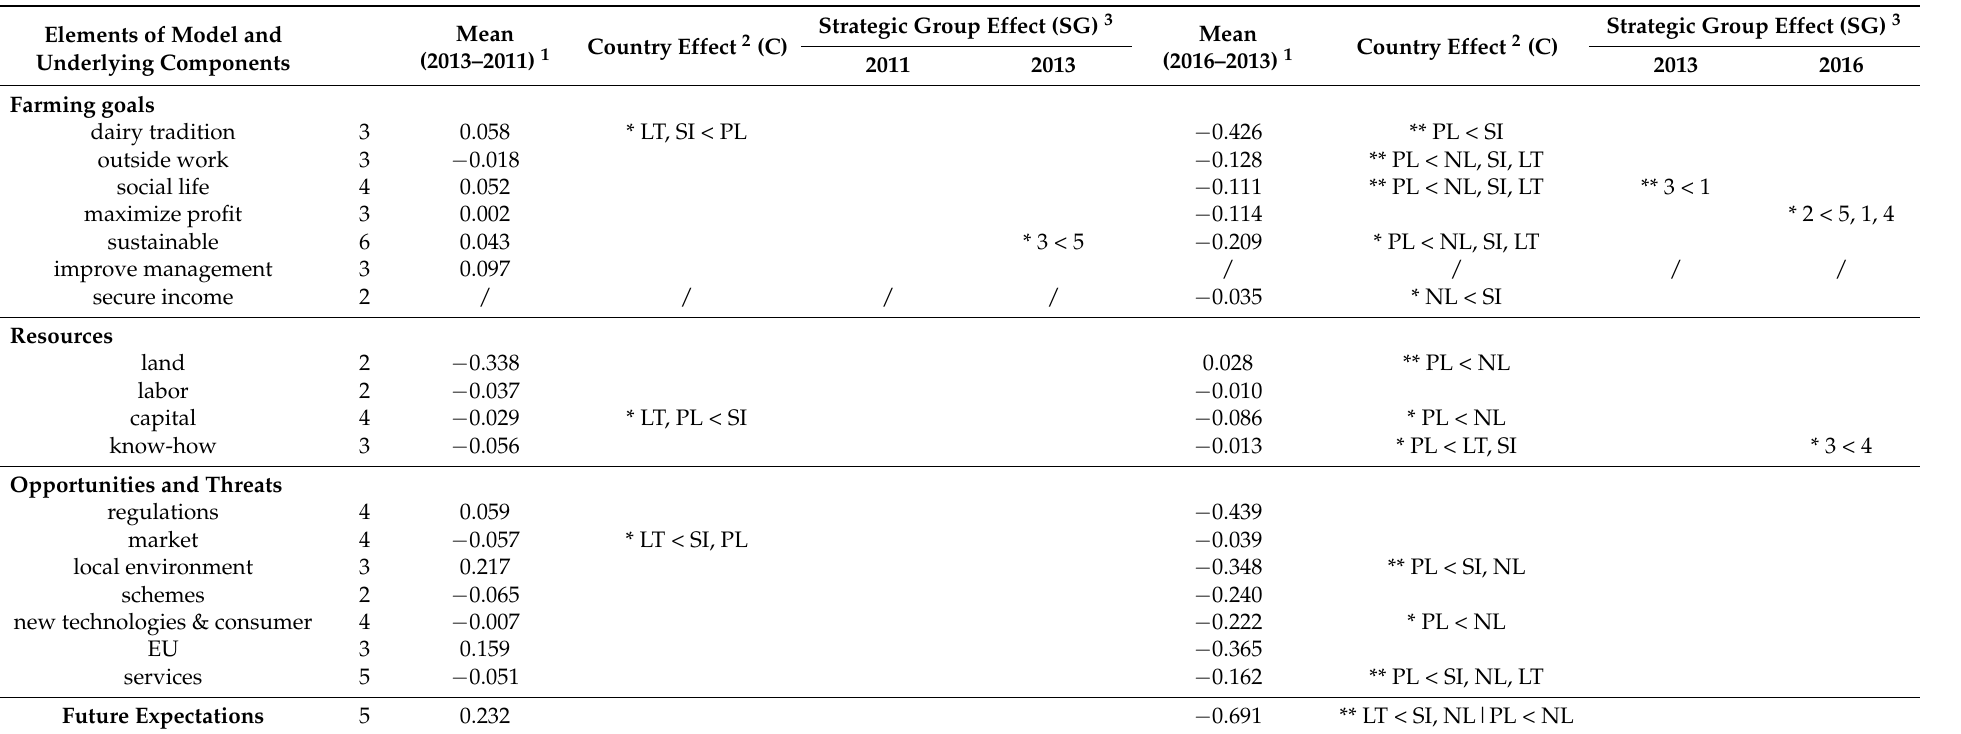
Table 5. Effect of country and strategic group on year differences in scores in Farming goals, Resources, Opportunities and Threats and Future prospects in periods 2011 to 2013 and 2013 to 2016, analysed by ANOVA